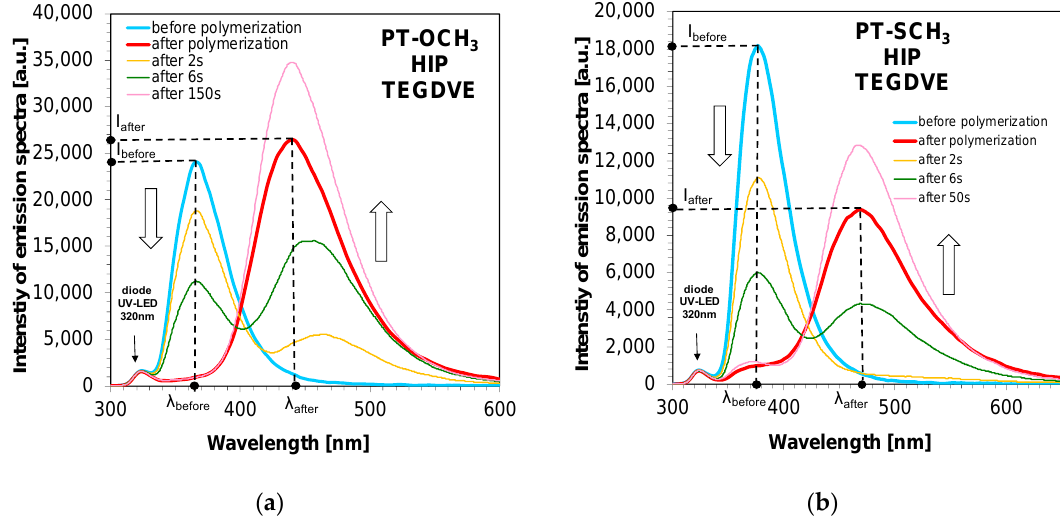
Figure 14. Changes of fluorescence spectra during cationic photopolymerization of TEGDVE monomer under irradiation at 320 nm for ( a ) PT-OCH 3 sensor and ( b ) PT- SCH 3 sensor.